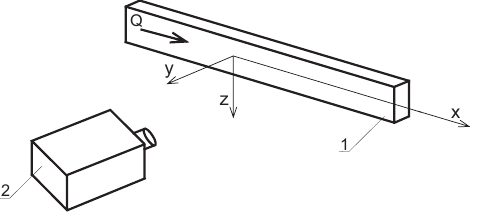
Fig. 1. Schematic picture of the measurement unit: 1 – copper fin; 2 – infrared